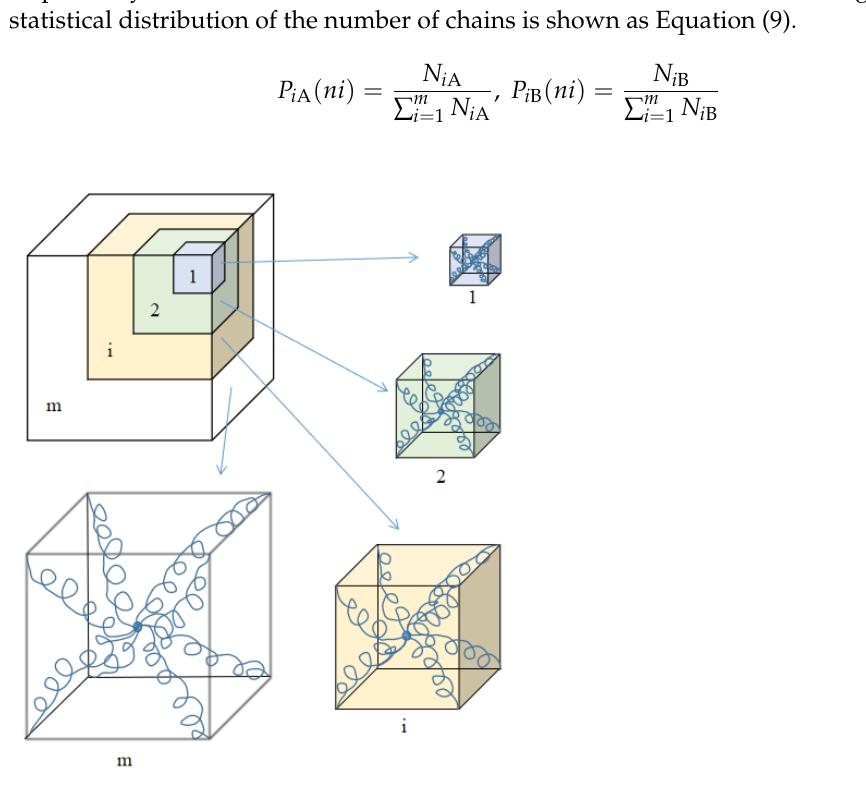
Figure 8. Schematics of an interpenetrating network model.